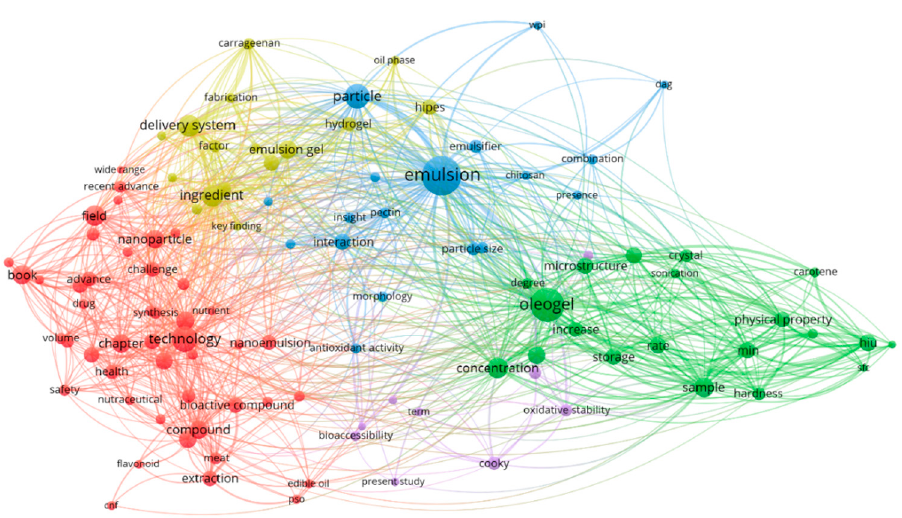
Figure 5. The network visualization of the publications (patents excluded).